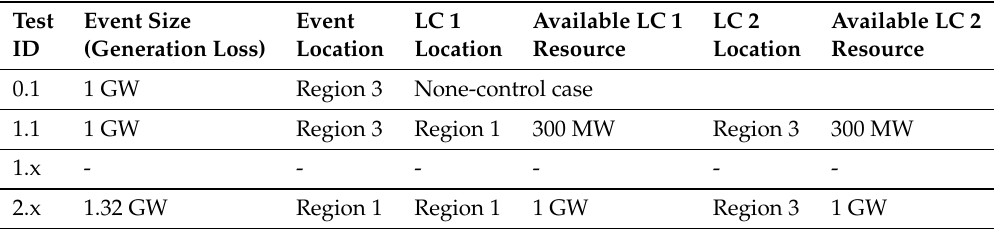
Table 3. Excerpt from test matrix specifying event sizes and initial